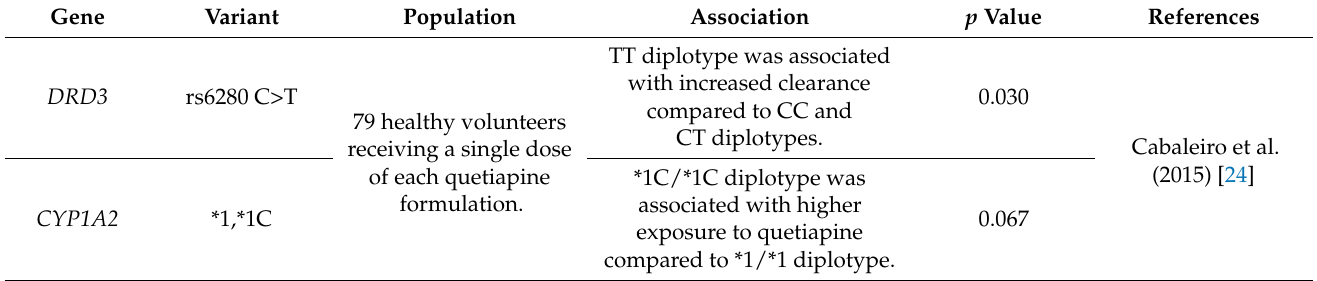
Table 4. Association between genetic variants and the pharmacokinetic effects of quetiapine